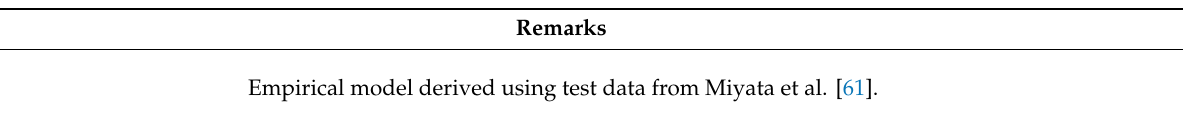
Table 1. Summary of equations used to predict the strength degradation of curved FRP